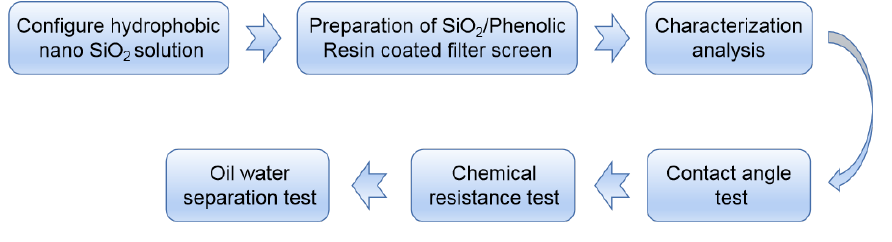
Figure 1. Test flow chart.